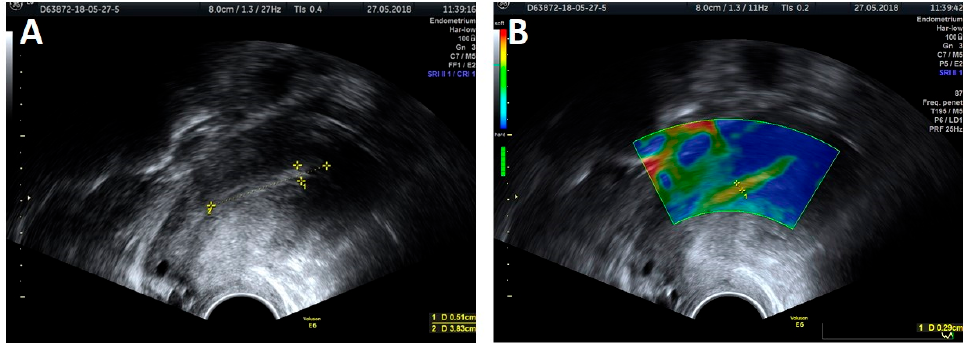
Figure 2. A 2D ultrasound presentation: endometrial thickness ( A ) and elastography: thickness measurement of the softest layer of the endometrium ( B ).